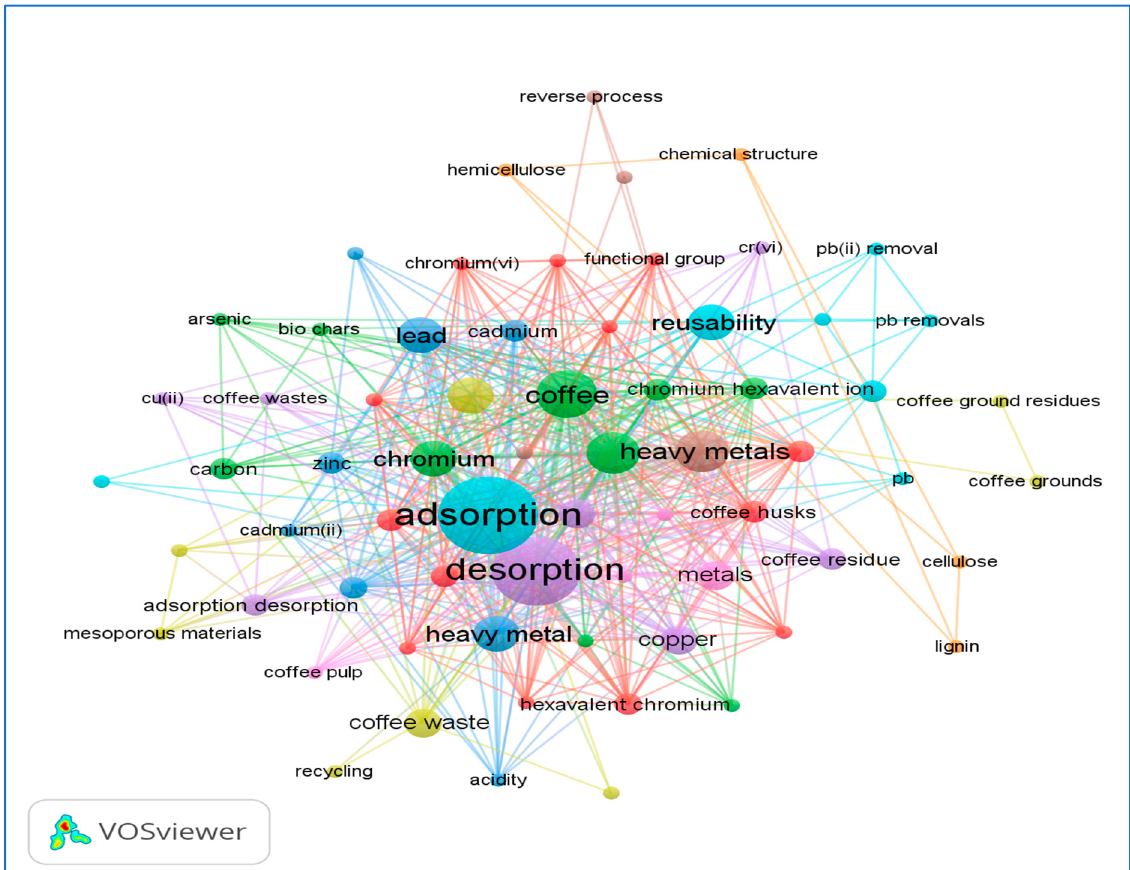
Figure 1. Bibliometric map related to co-occurrence of terms against the search from 2000 to the present for “desorption” AND “coffee” AND “heavy metals” (elaborated with Scopus metadata using VOSviewer 1.6.18 Software).